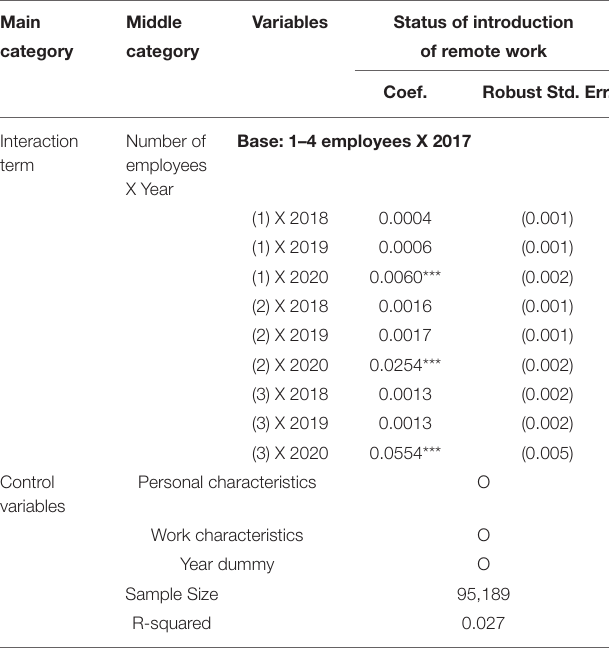
TABLE 7 | Robustness check of Table 4 ’s